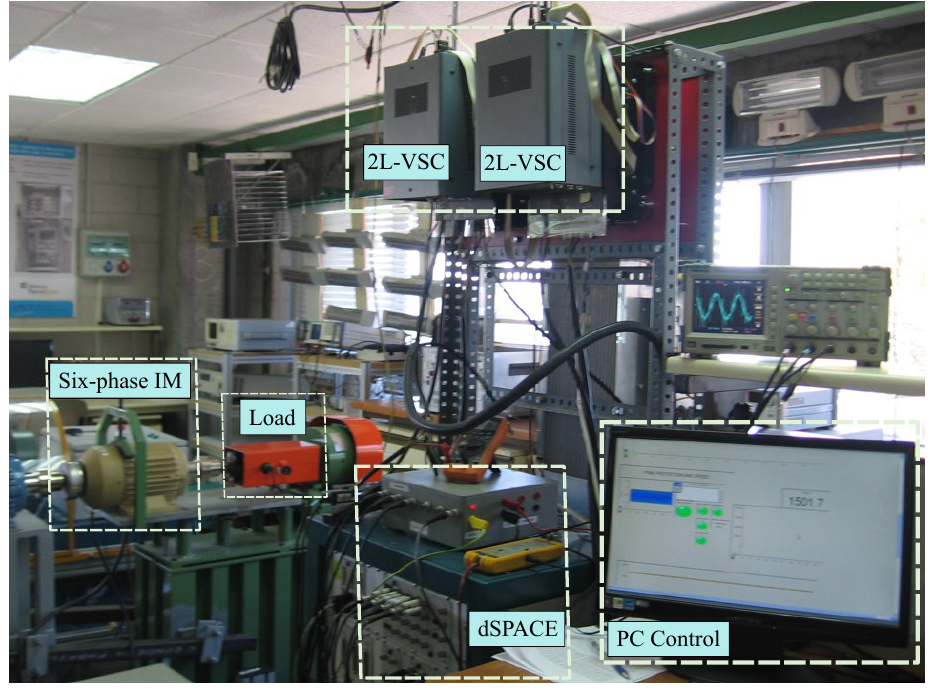
Figure 3. Experimental